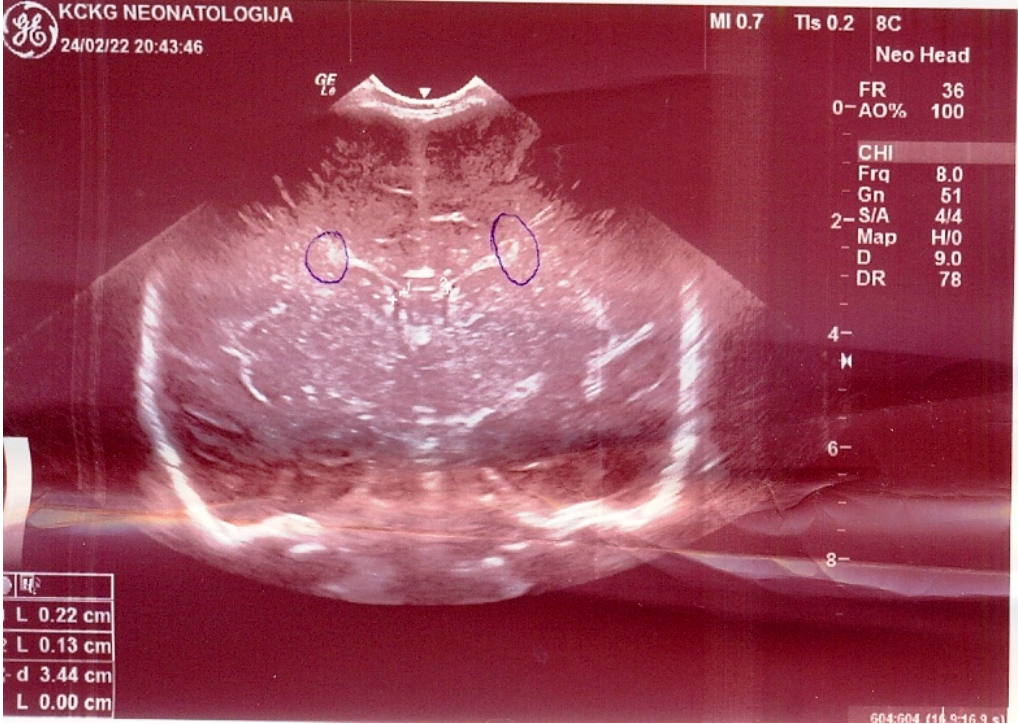
Figure 2. Ultrasound finding of the brain: The brain edema and on the right periventricular hy- perechogenicity, the degree I, in newborn 1. Chambers easily asymmetric, VPRD = 2.2 mm, VPRL = 1.3